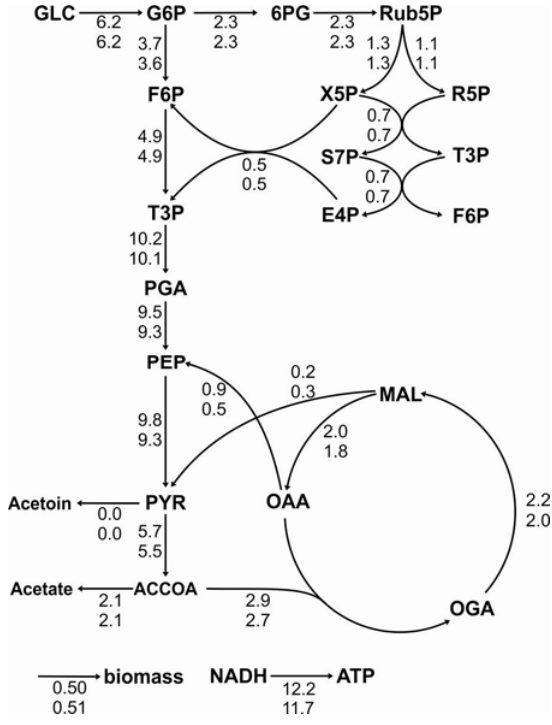
Figure 5. Metabolic flux charts of the B. subtilis central carbon metabolism. The flux chart presents data from two flux distributions with the reactions rates plotted next to the reaction arrows. The flux values are given in mmol g CDW-1 h -1 and are calculated with Flux-P (top) and FiatFlux (bottom), respectively. Raw data taken from